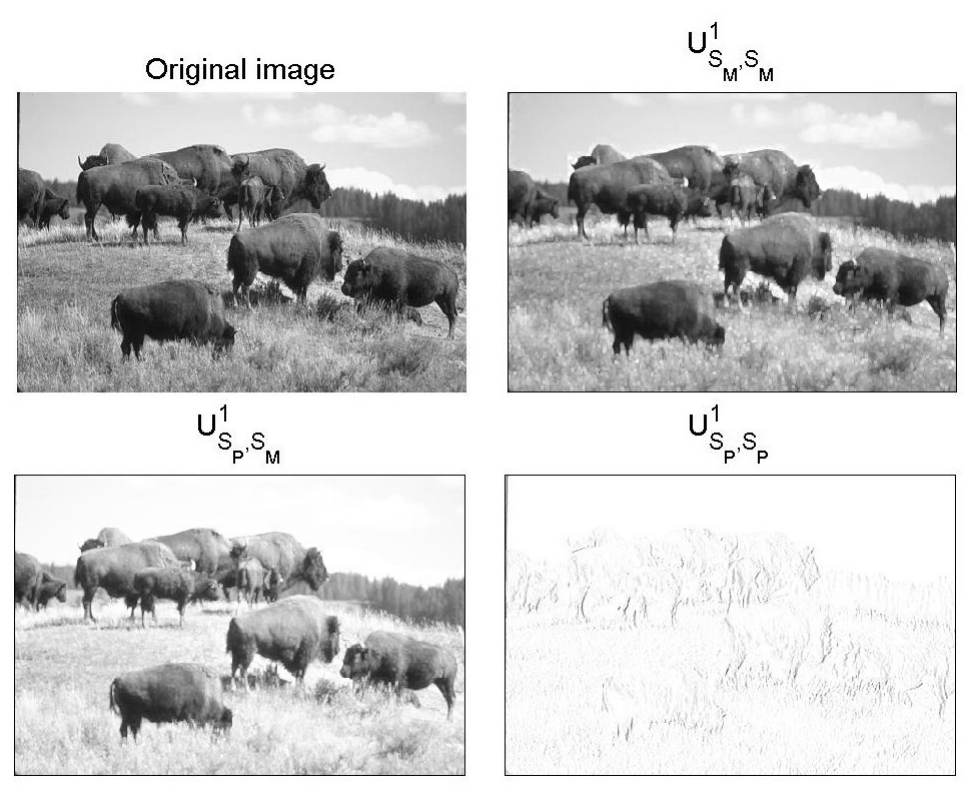
Figure 3: Comparative of lower constructors depending on the t-conorms. S P is the probabilistic sum t-conorm and S M the maximum